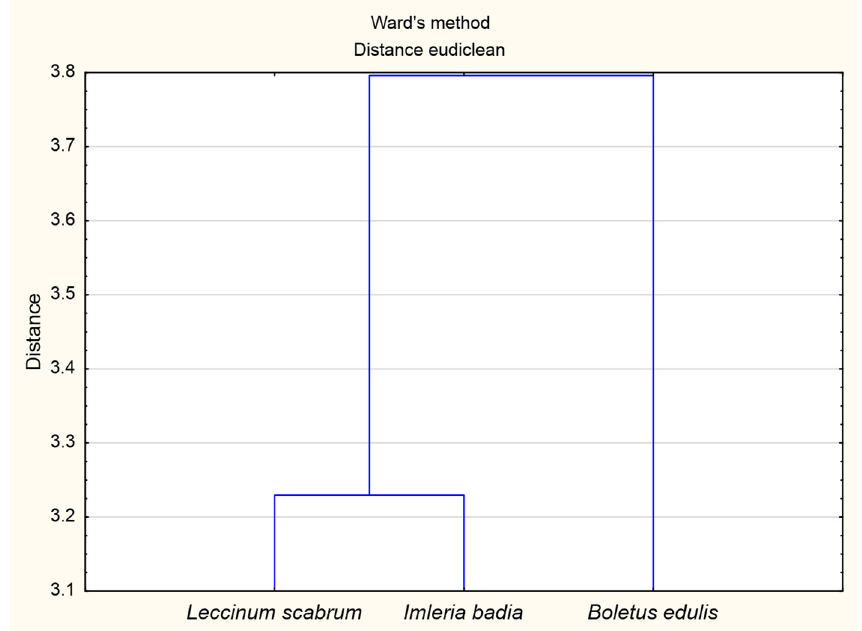
Figure 2. Ward’s cluster analysis for macronutrients content in soils where the mushrooms grew ( L. scabrum , I. badia , B. edulis ).